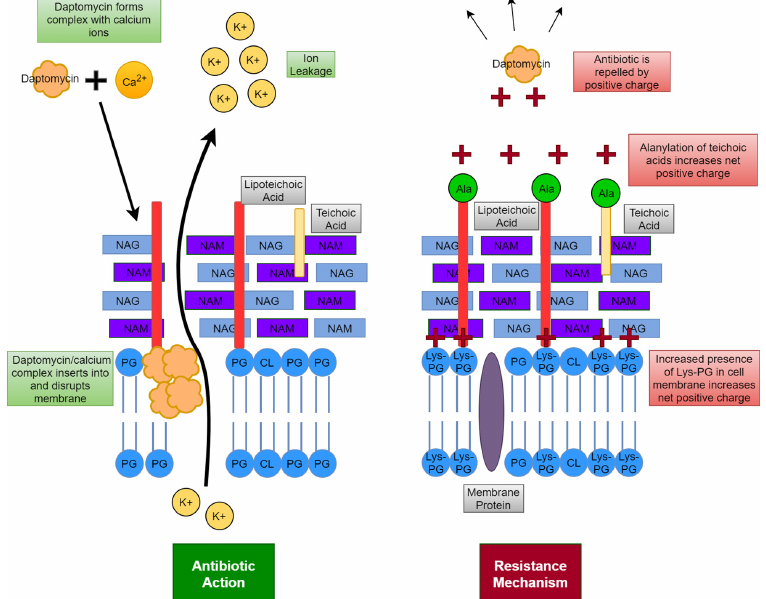
Figure 5. Antibiotic action of daptomycin against S. aureus and resistance mechanisms used by S. aureus against daptomycin.